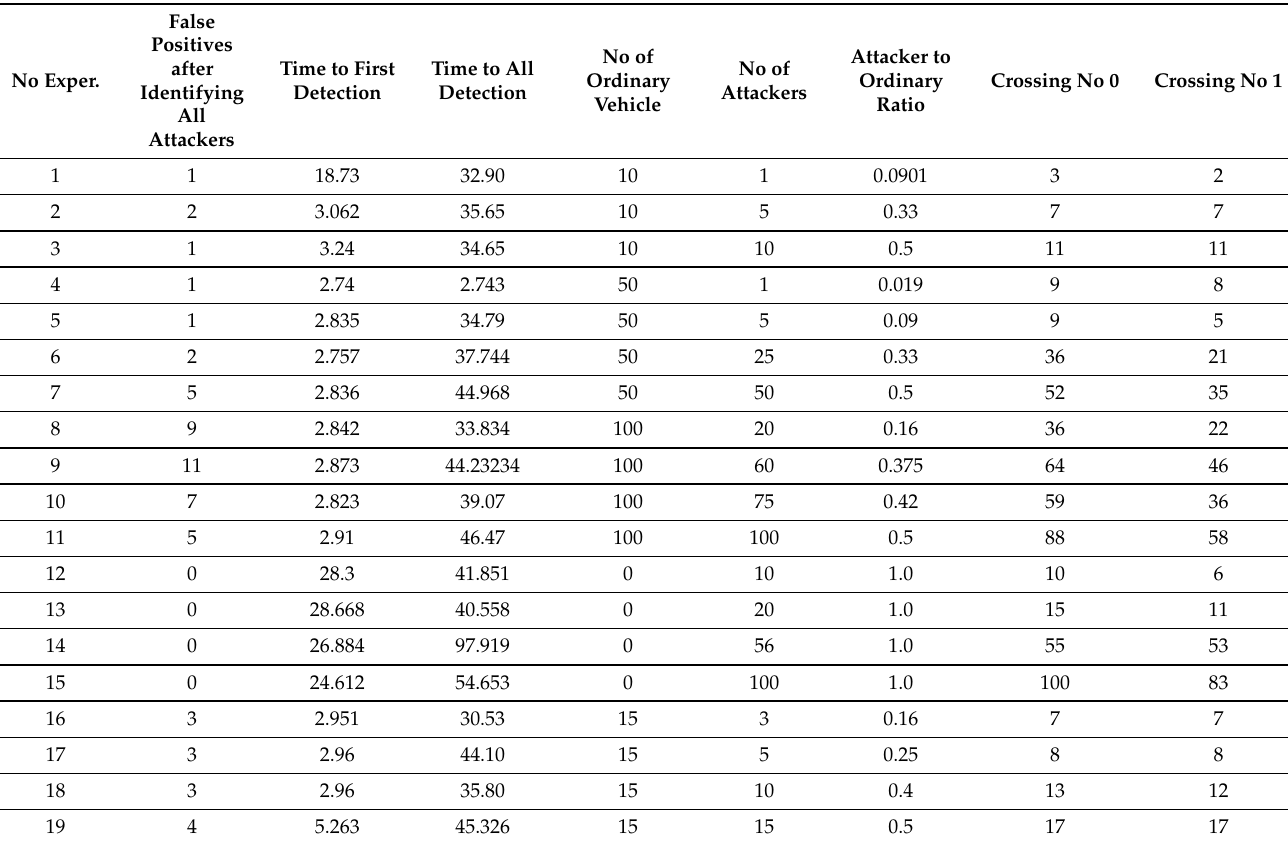
Table 7. The results of experiments after code improvements implementing the Bogus & Sybil Enhanced Behavior Processing & Footprint